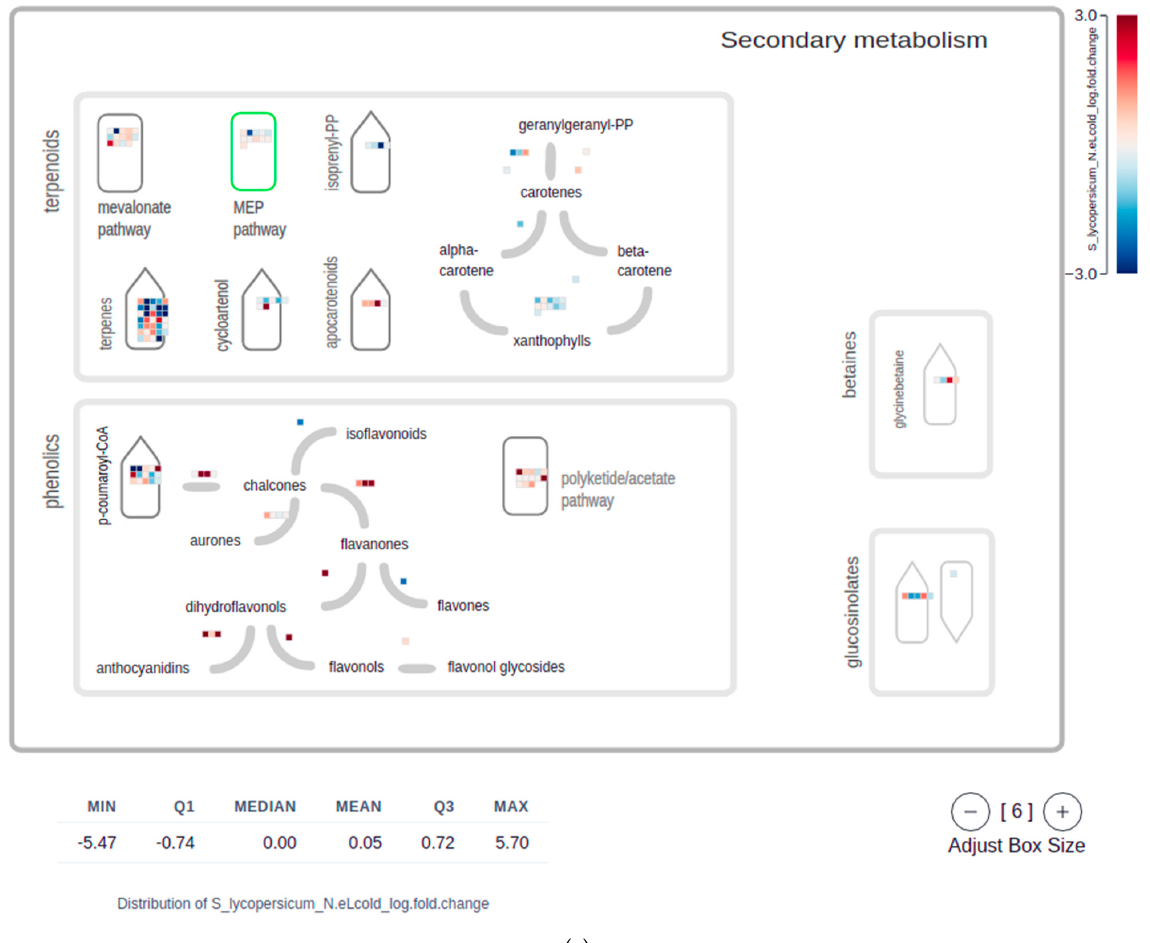
Figure 4. Screenshots of Mapman plots [1,2] used to visualize the genetic response to experimental stimuli in the form of metabolic sketches. Genes are mapped to areas in the sketches according to their molecular function. This gene function is directly extracted from the respective Mapman Bins [36] the genes are assigned to [3]. Each gene is represented by a single-colored box, where the color represents a numeric value, in this example the logarithmic fold change of gene expression (log-FC) between control and stress treatment. A legend in the top-right corner informs about the color-scale used to represent these numeric values. At the bottom of each Mapman plot, a summary statistic informs the user about the distribution of the respective numerical values, here the log-FC, shown in the plot. An interactive control in the bottom-right corner allows the user to adjust the sizes of the boxes, each representing one gene. Plot ( a ) shows a metabolic overview sketch and highlights how in the example data the expression of genes associated with photosynthesis is down regulated in S. lycopersicum following stress treatments (blue boxes in the respective top-right corner matrices). This down-regulation particularly affects genes of the light reaction, calvin cycle, and photorespiration pathways. Plot ( b ) sheds more light on this genetic response and zooms into the effect of stress treatments on the expression of genes associated with Photosystem I and II. Another detailed representation of the observed genetic response to stress treatment is shown in plot ( c ), elucidating how the expression of genes involved in terpene and carotene synthesis is down-regulated in S. lycopersicum